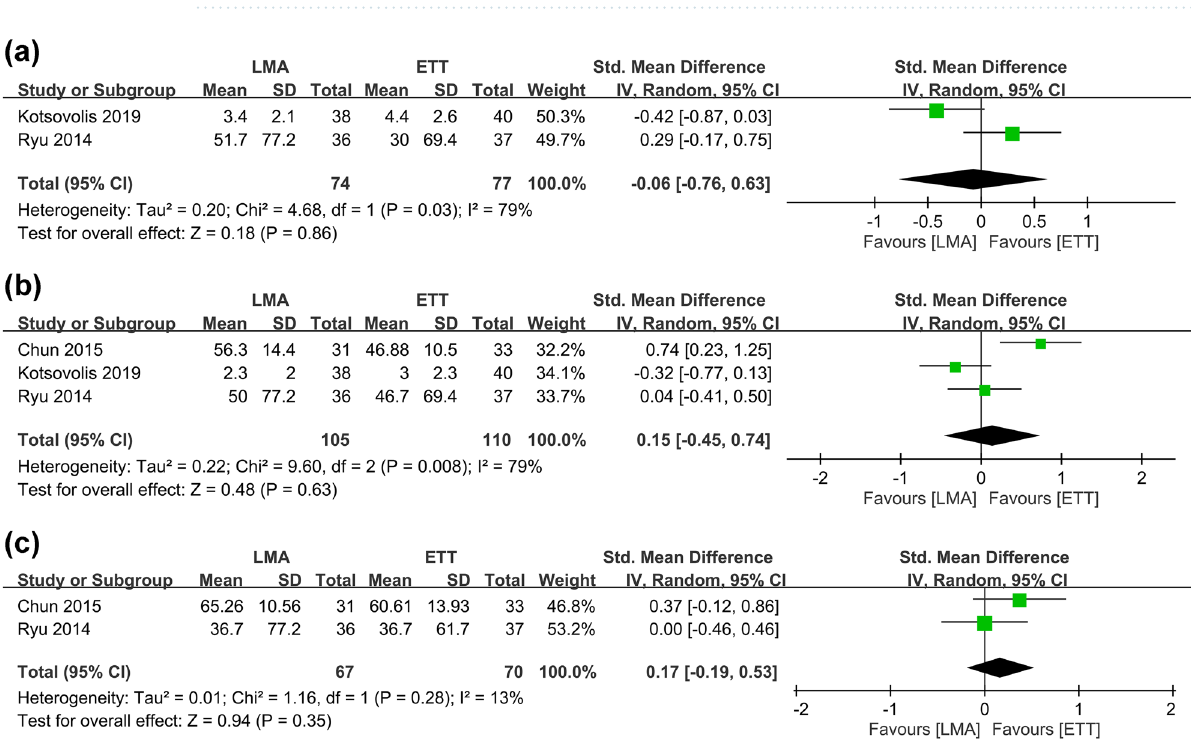
Figure 7. Forest plot comparing the severity of dysphagia at ( a ) 1 h, ( b ) 24 h, and ( c ) 48 h between laryngeal mask airway (LMA) and endotracheal tube (ETT) groups. CI confidence interval, IV inverse variance, Std